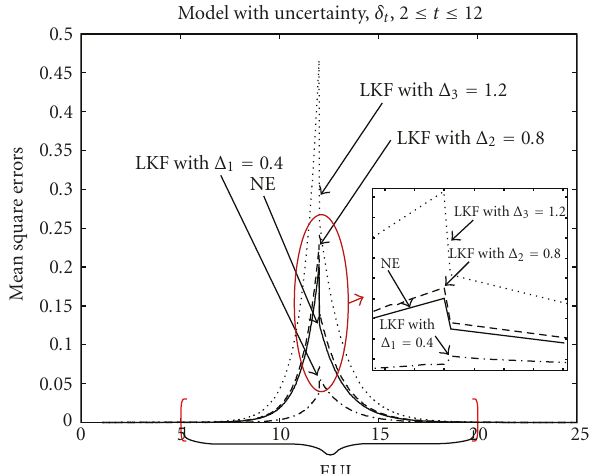
Figure 3: MSEs comparison between NE-DFRHF and three LRHKFs inside the